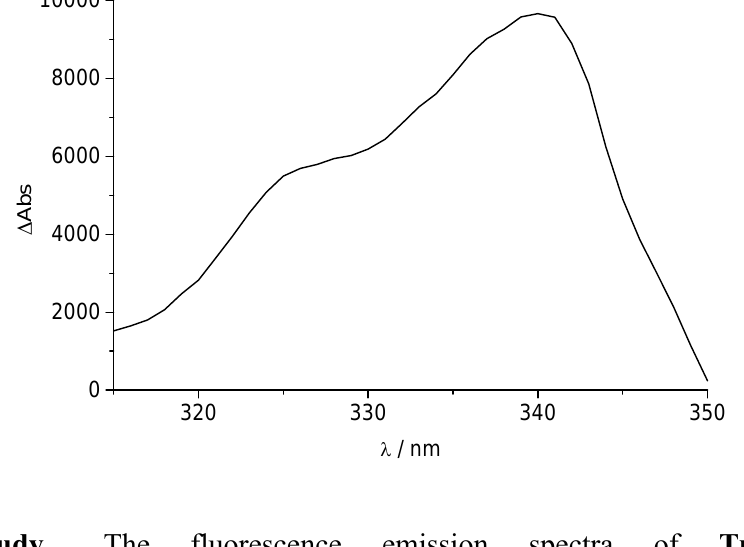
from the one of Zn(TpyPhPyrene 2